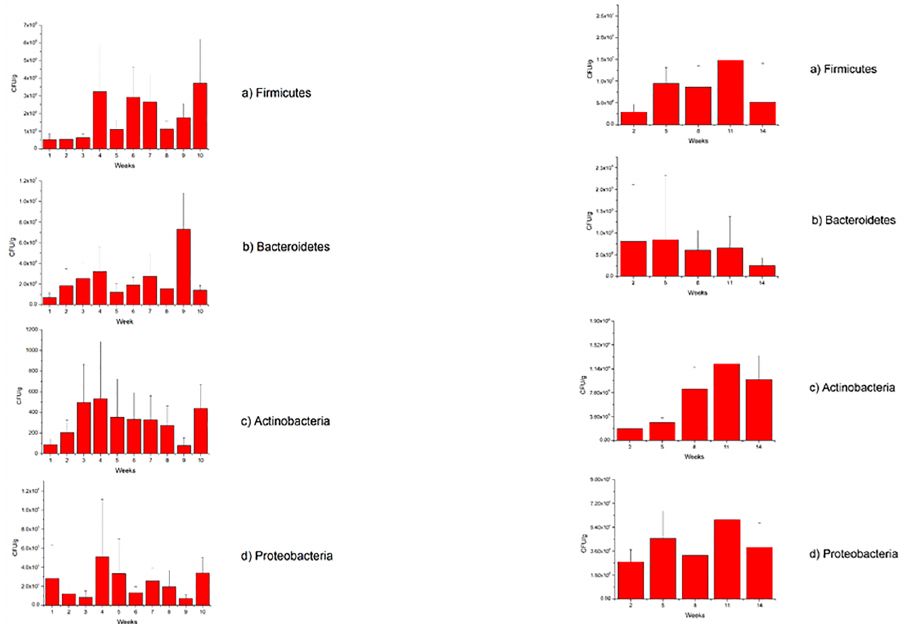
Fig 1. a. Mean abundance of the major phyla; Actinobacteria (a), Bacteroidetes (b), Firmicutes (c) and Proteobacteria (d) duringdevelopment in little penguin chicks b. Mean abundanceof the major phyla; Actinobacteria (a), Bacteroidetes(b), Firmicutes (c) and Proteobacteria (d) duringdevelopment in short-tailed shearwaterchicks.